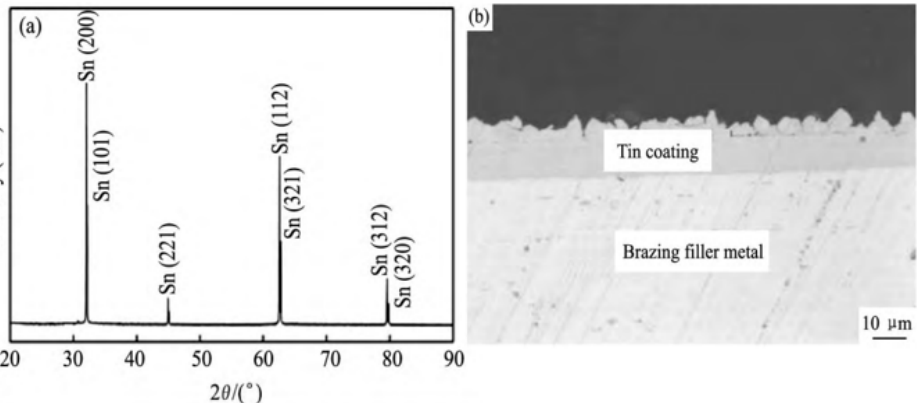
Figure 8. Analysis results of BAg34CuZnSn filler metals with a plated Sn coating: ( a ) XRD spectrum of the Sn coating; ( b ) interface morphology [34].